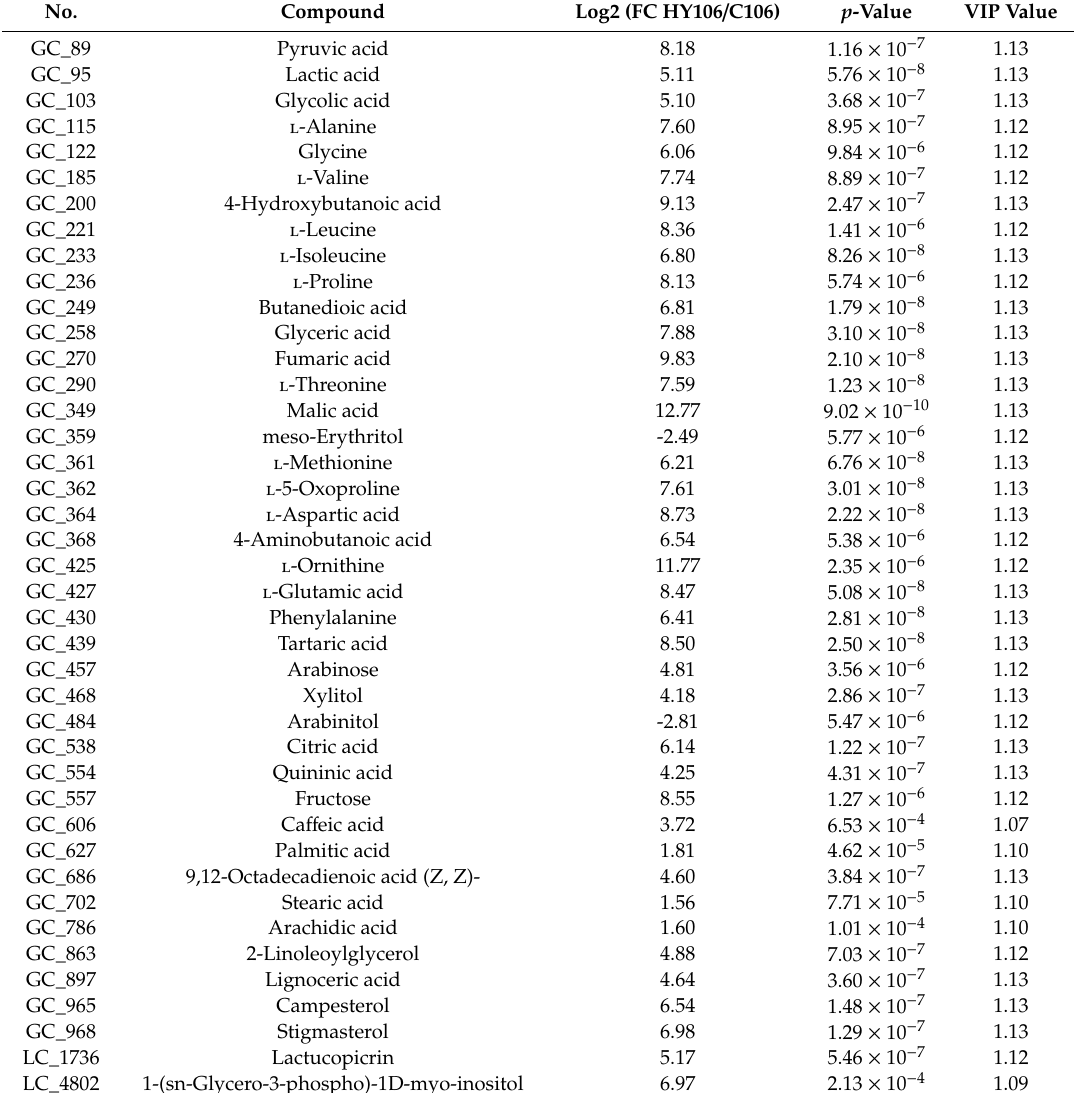
Table 3. Di ff erential metabolites detected between buds of S15k0106 seeds germinated at 35 ◦ C (HY106) and 21 ◦ C